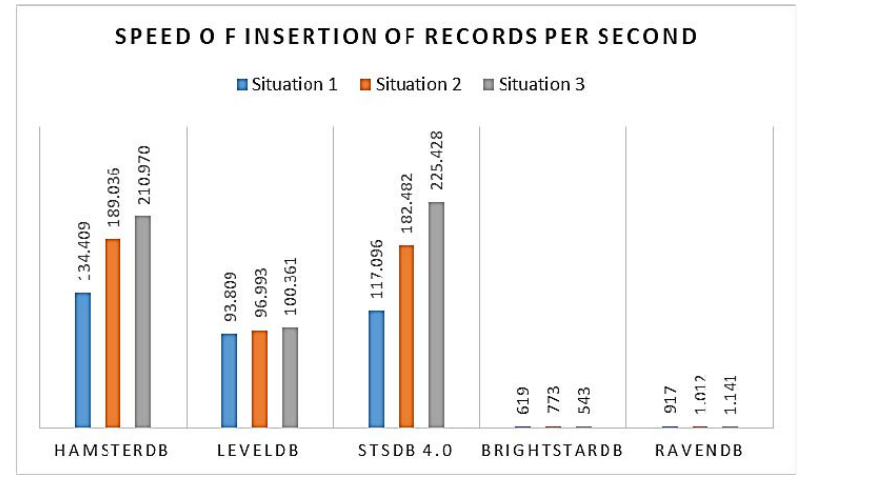
Figure 3 – Speed of insertion of records per